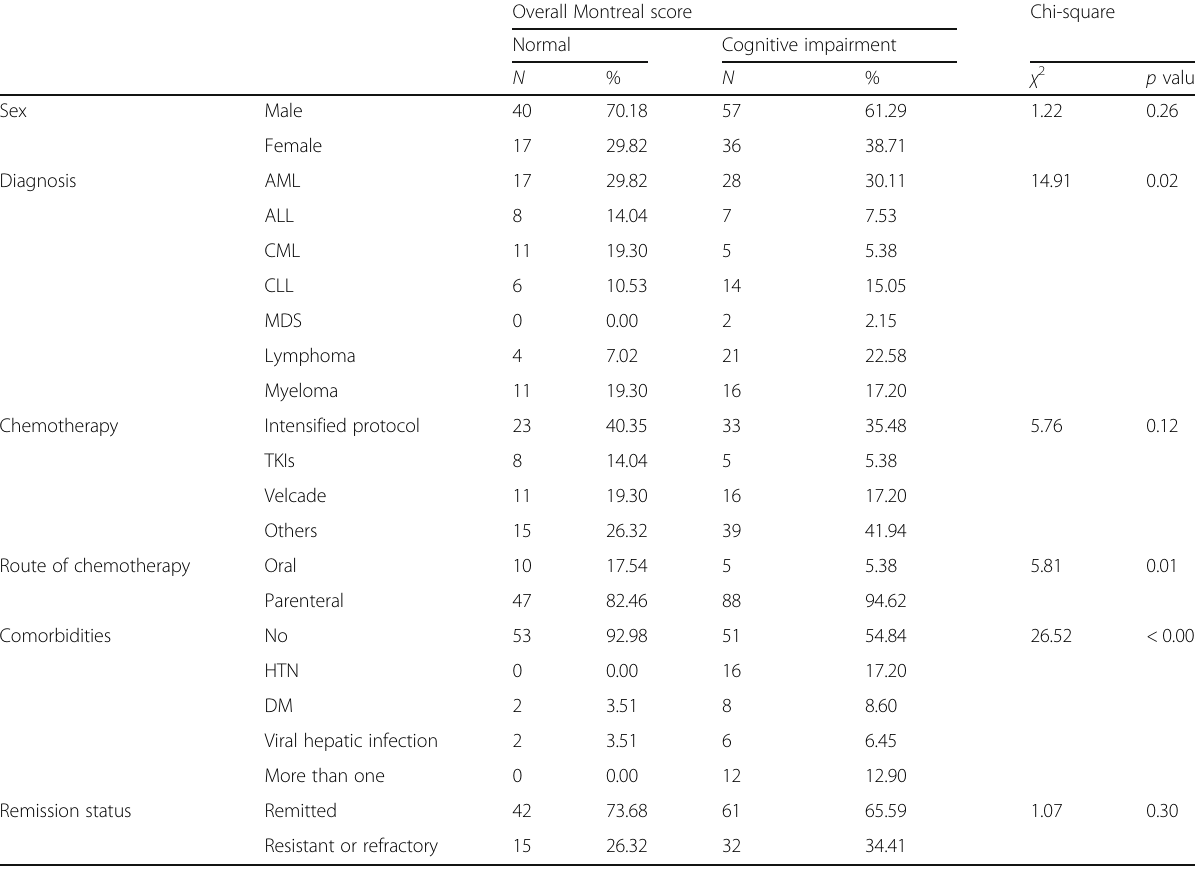
Table 2 Comparison between group of patients with normal overall Montreal score and those patients with abnormal score Overall Montreal score Chi-square